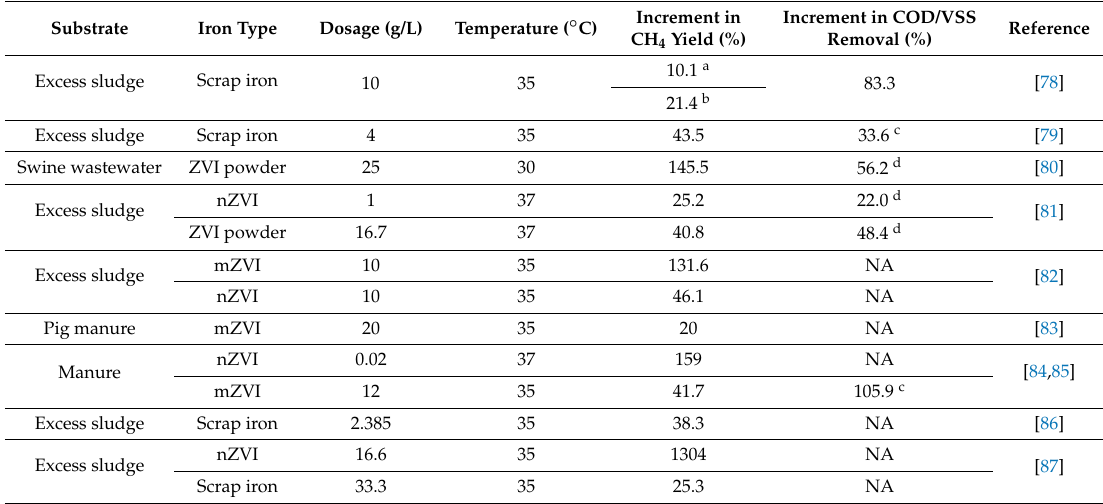
Table 2. Summary of anaerobic digestion enhanced by